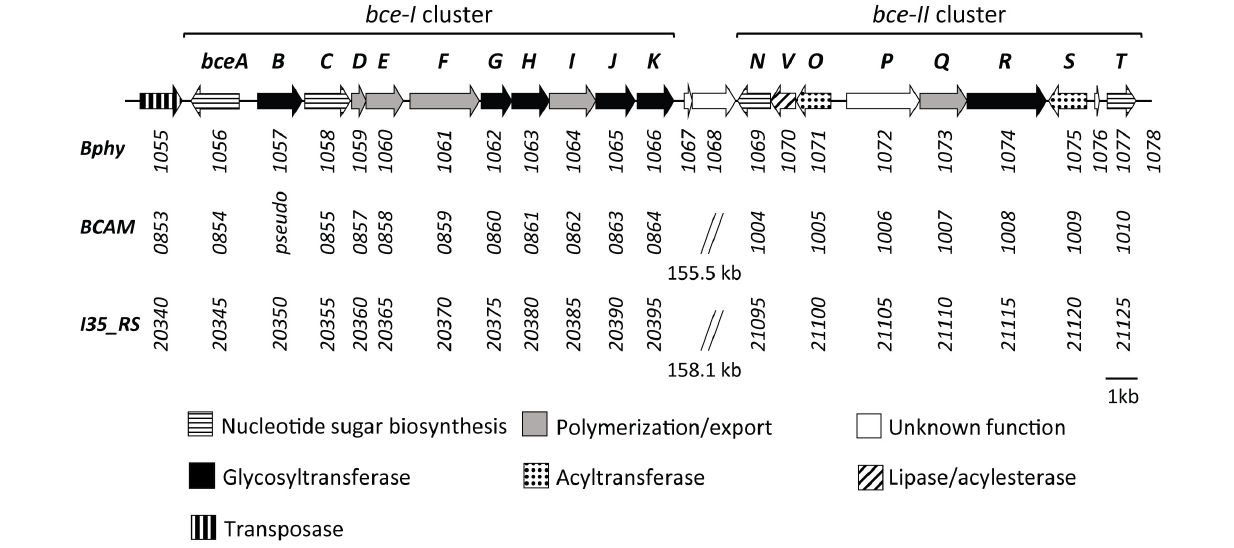
FIGURE 1 | Genetic organization of the bce gene clusters in P. phymatum STM815 (Bphy) in comparison with B. cenocepacia J2315 (BCAM), and B. cenocepacia H111 (I35_RS). Gene numbers are listed under each gene indicating a sequential arrangement of genes in two bce clusters ( bce -I and bce -II), which are either continuous or separated. Functional categorization adapted from Ferreira et al.